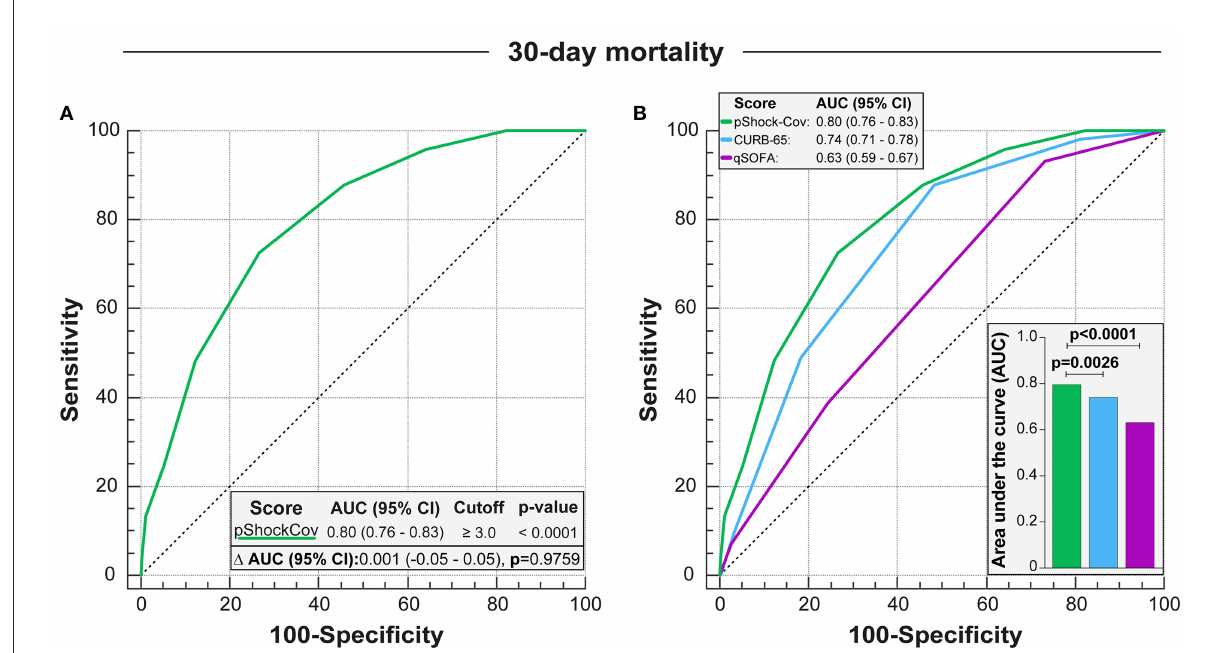
FIGURE4 Discrimation of pShock-CoV over prediction of 30-day mortality for patients with COVID in ICU and comparison with other severity models. (A) Perfomance of the pShock-CoV score in predicting 30-day mortality in the intensive care unit, and comparison with discrimination capacity for overall mortality. (B) Comparison pShock-CoV with CURB-65 and qSOFA for prediction of ICU 30-day mortality in COVID patients. Differences between AUC-ROCS were accessed by the DeLong